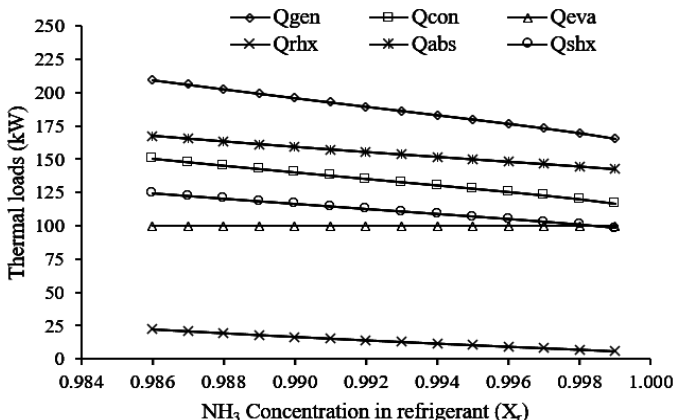
Figure 18. Variations of thermal loads with X r .